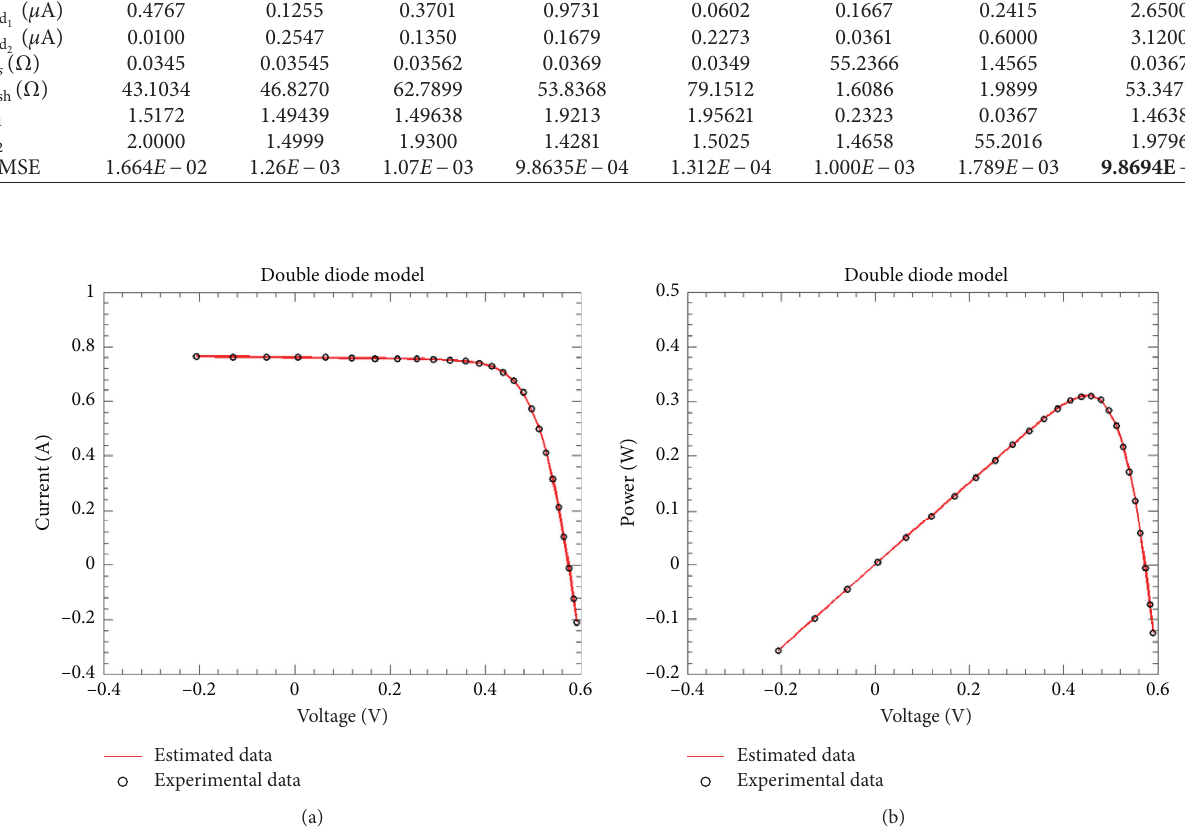
Figure 7: I-VC (a) and P-VC (b) of the best DDM obtained based on